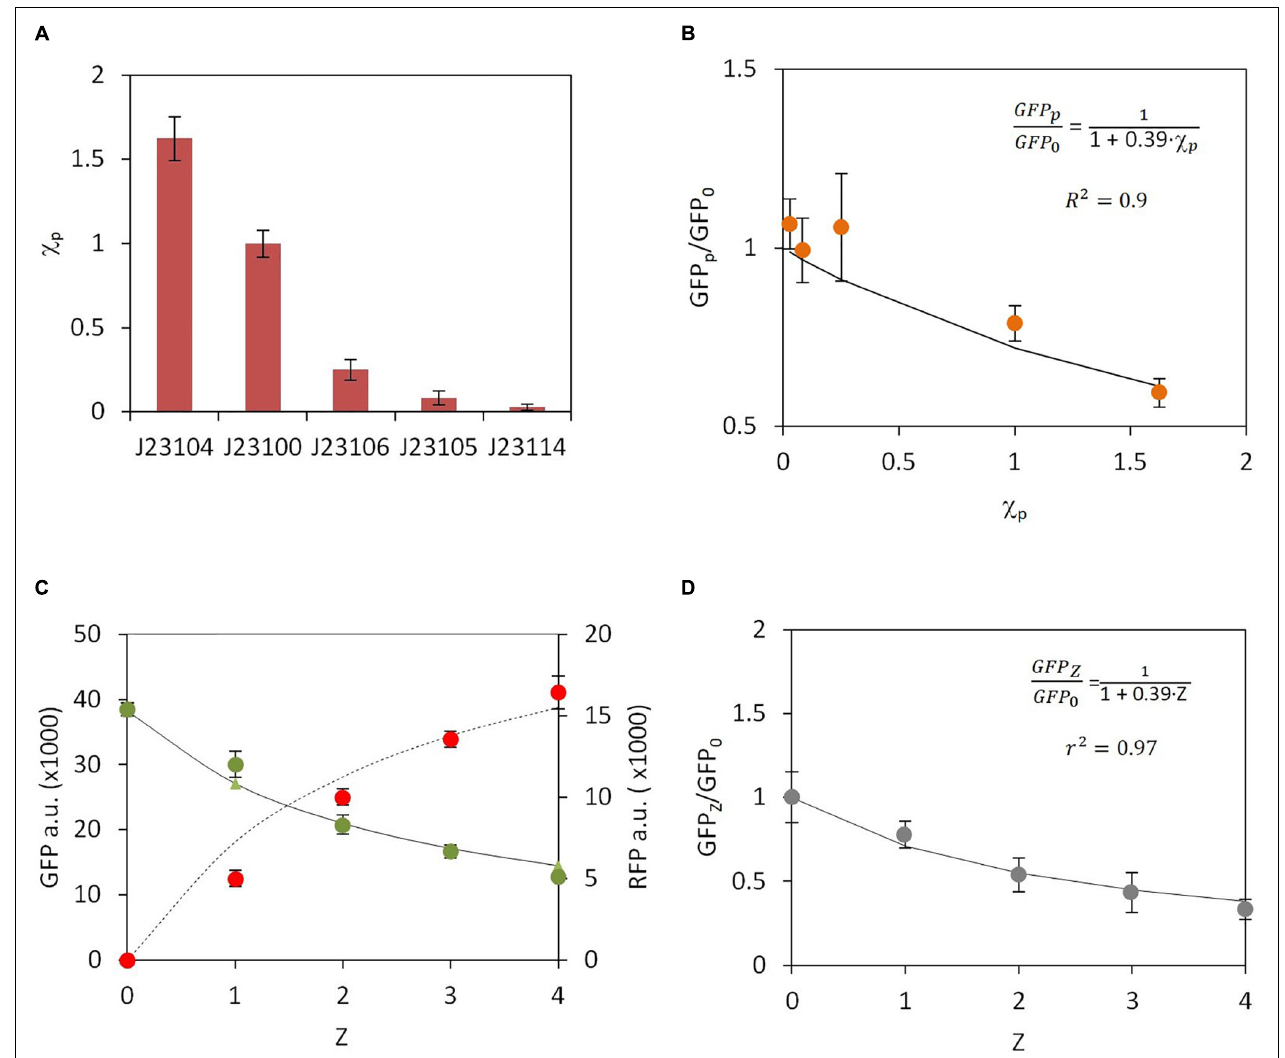
FIGURE 2 | Experimental data and model fitting for constitutive gene expression. (A) Experimental measurement of relative promoter activity χ p . RFP expression was monitored for each promoter. Promoter J23100 was chosen as a reference. (B) Change in the ratio of GFP levels in the absence (GFP 0 ) and upon RFP promoter activity increase (GFP p ). Orange dots, experimental data; solid line, model fitting. (C) Changes in GFP (green dots) and RFP (red dots) levels, indicated as arbitrary units (a.u.), upon increase in the number of RFP copies, Z. Solid line, GFP model fitting; dashed line, RFP model fitting. (D) GFP fold change versus increasing number of RFP copies